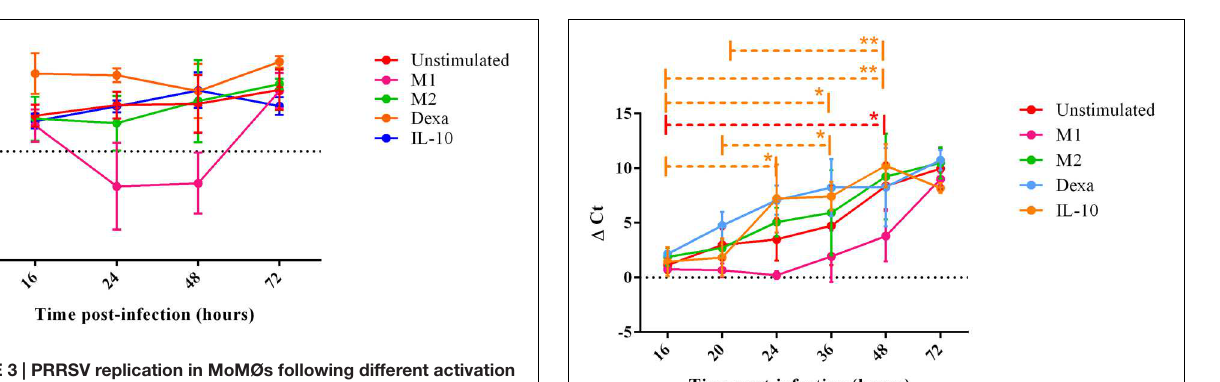
FIGURE 3 | PRRSV replication in MoMØs following different activation stimuli. Monocytes were treated with M-CSF for 4 days to generate MoMØs, and either left unstimulated (red) or activated with LPS and IFN- γ (M1; pink), IL-4 (M2; green), dexa (orange) or IL-10 (blue) for 24 h before infection with PRRSV Lena using an m.o.i of 0.1. RNA was extracted from cells at either 16, 24, 48, or 72 h p.i, and a TaqMan qPCR was used to quantify PRRSV RNA. (cid:49)(cid:49) C t represents difference between C t at 2 h p.i (time zero) and C t at each time point p.i after normalization against 18S RNA. Bars represent mean (cid:49)(cid:49) C t ± SD.